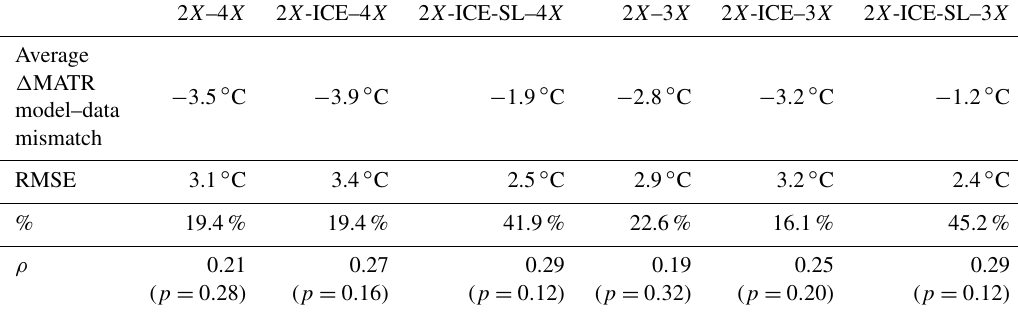
Table 2. Priabonian–Rupelian data–model comparison. Negative mean (cid:49) MATR values reflect a tendency of the model to underestimate (cid:49) MATRs. The line “%” gives the percentage of sites where the direction of (cid:49) MATR is adequately modeled (e.g., the model described a MATR reinforcement in the zone where data indicate MATR increase). Modeled (cid:49) MATR estimates were regarded as positive when > 0 . 5, negative when < 0 . 5, or null when in the range of [ − 0 . 5; 0.5]. ρ indicates the strength of the correlation estimated with the Spearman rank test, with associated p values ( p ). Note that with all p values being > 0 . 05, none of the correlations are significant. 2 X –4